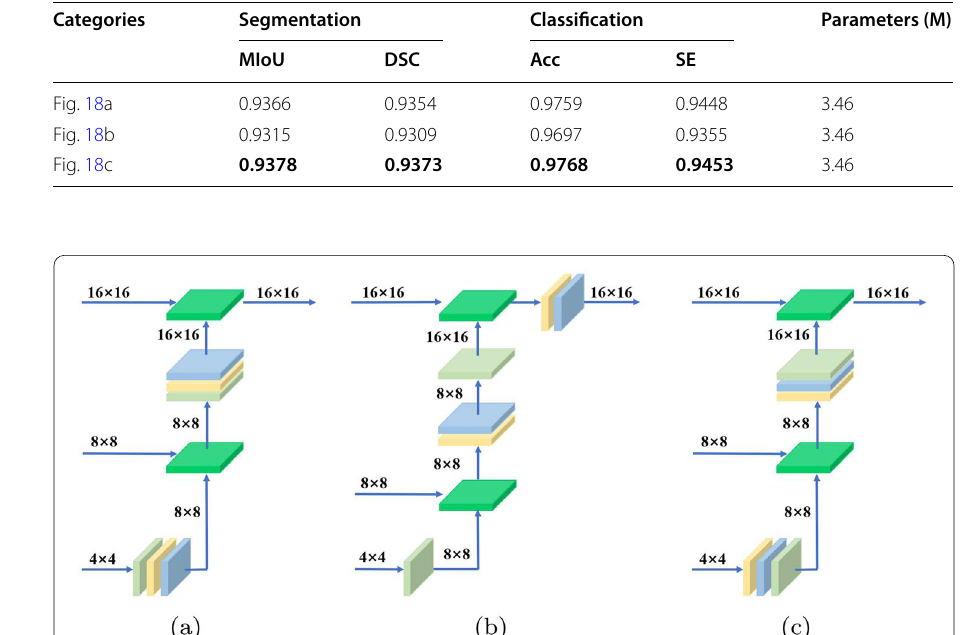
Fig. 18 Different arrangements of feature fusion in HR-MPF. a – c provide an example of the 16 × 16 feature fusion pathway in Stage3 (Fig. 3)